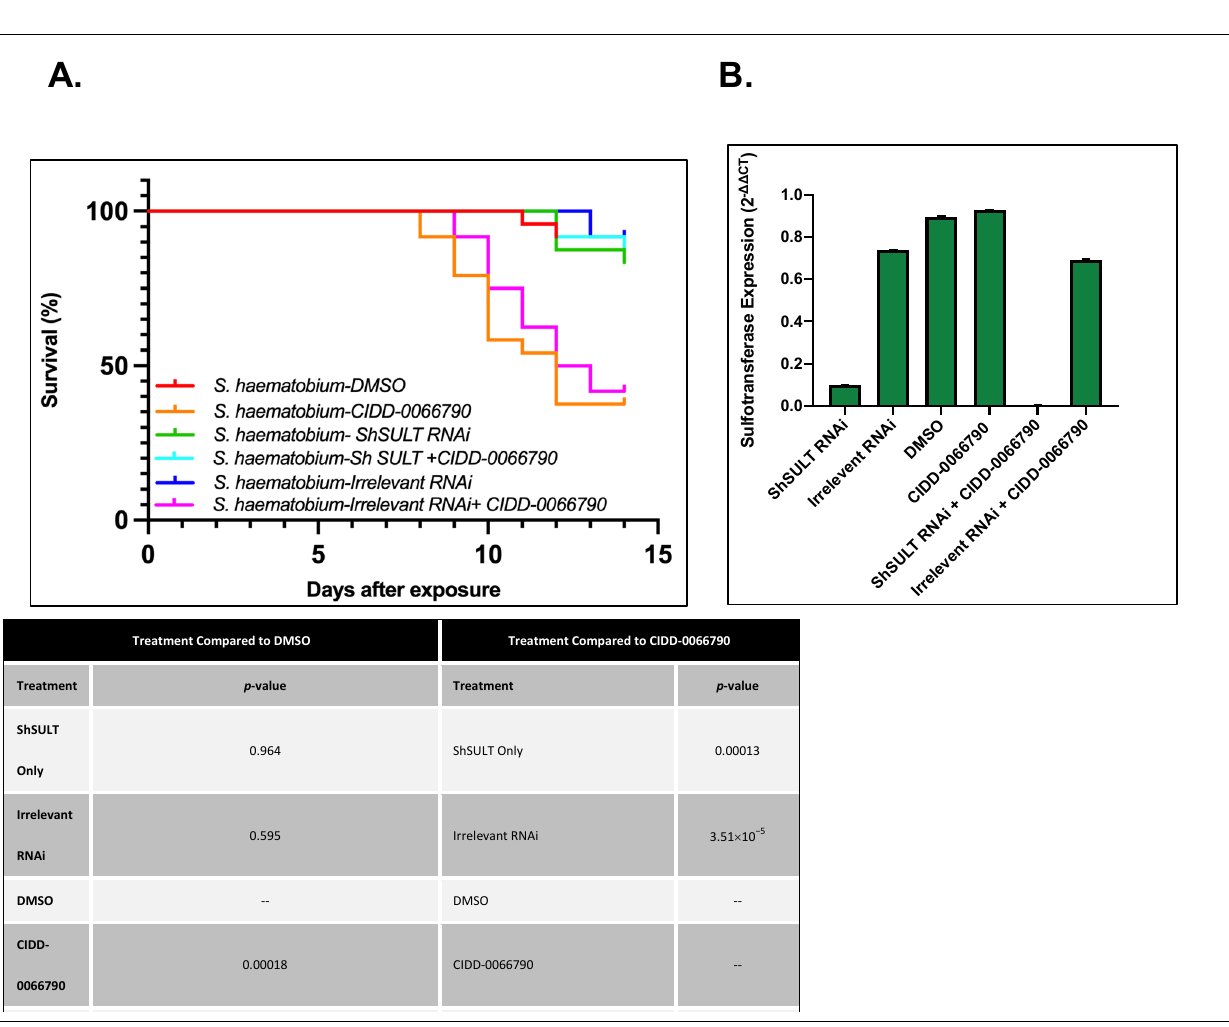
Figure 3. Silencing of ShSULT results in resistant parasites upon challenge with CIDD-0066790. ( A ) Kaplan-Meier survival curve of S. haematobium parasites. Survival curve analysis of adult, male S. haematobium parasites challenged with CIDD-0066790 with or without RNAi treatment. Parasites were cultured for 14 days. RNAi treatment occurred as stated in schematic above of Figure 1A.